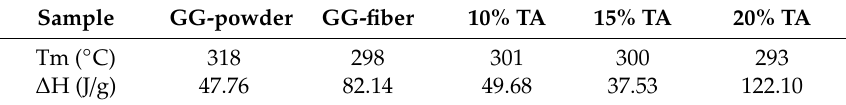
Table 3. Thermodynamic properties of the neat GG and GG fibrous mats loaded with TA.